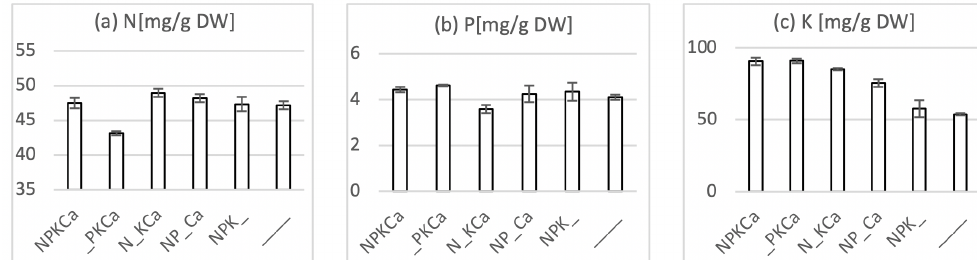
Figure 4. Nutrient contents of young sugar beet leaf blades at the LTFE Dikopshof Wesseling harvested on 13 June 2019. Pooled samples of shoots from five plants grown under fertilization treatments, as indicated were dried for seven days at 60 ◦ C. Approximately 7 mg of ground plant material was subjected to N determination by an elemental analyzer. Three measurements were performed on the same sample. Three independent digestions of approximately 500 mg were generated by nitric acid digestion and then subjected to either K-determination by flame photometry or P-determination by ICP-OES. Error bars indicate standard deviation. Note that, since samples were pooled, standard deviation only accounts for uncertainty in